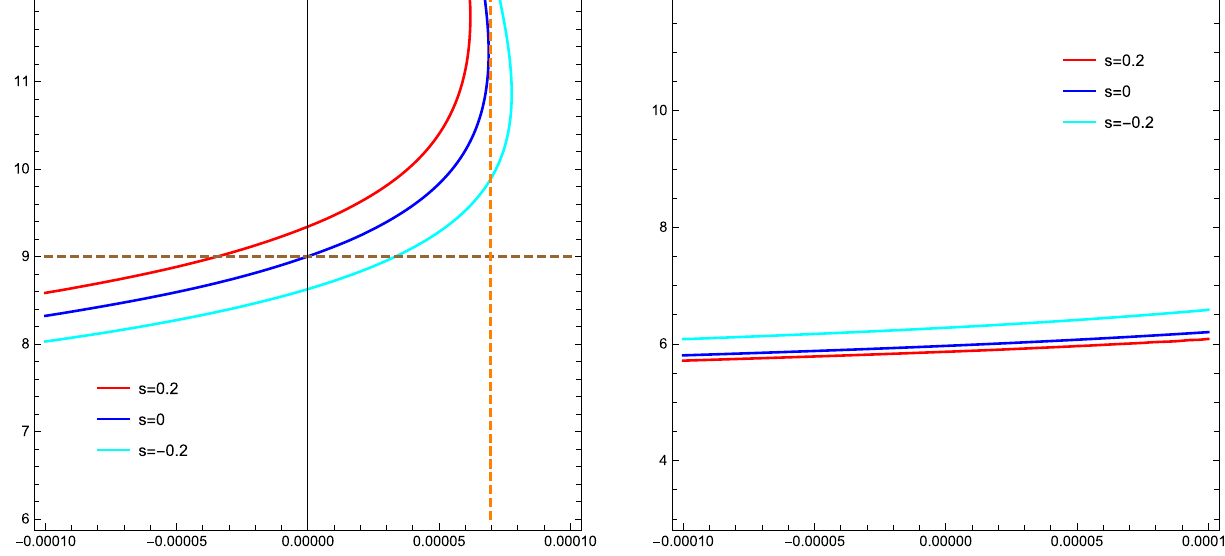
Fig. 7 ISCO radius in term of L for counter-rotating test body with a / M = 1. The counter-rotating case corresponds to r ISCO / M = 9 at (cid:2) = 0. For L > 0 . 0000695, orange dashed line, r in case of zero spin for a / M = 1